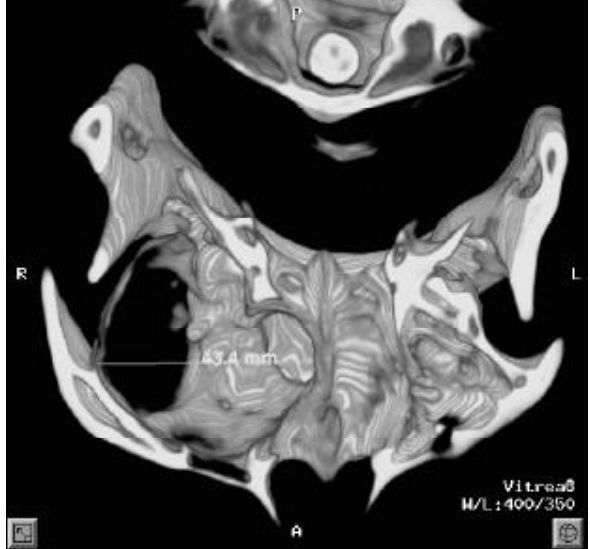
FIGURE 3- 3D-CT supero-inferior view using bone protocol is demonstrating the electronically measurement of right maxillary sinus’ medio-lateral largest diameter